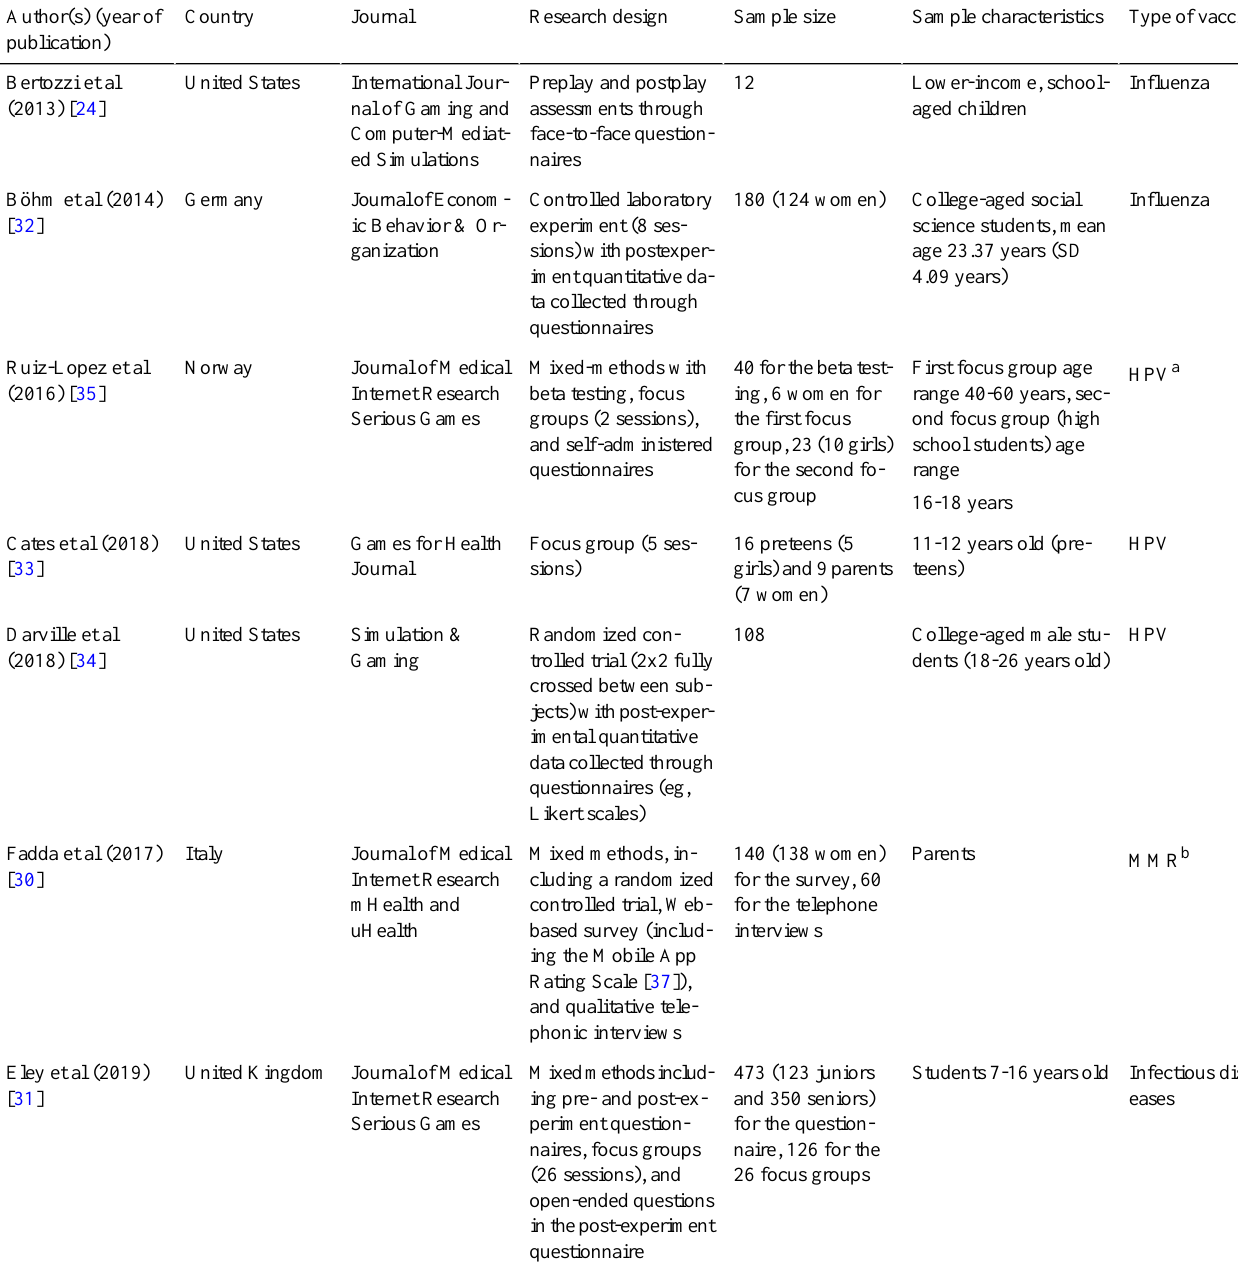
Table 1. Summary of the characteristics of the 7